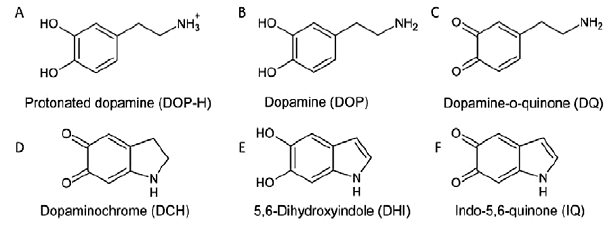
Figure 1. Dopamine and the oxidation derivatives known to interact with a -syn. (A) Protonated Dopamine (DOP-H), (B) Dopamine (DOP), (C) Dopamine-o-quinone (DQ), (D) Dopaminochrome (DCH), (E) 5,6-Dihydroxyindole (DHI), (F) Indol-5,6-quinone (IQ).